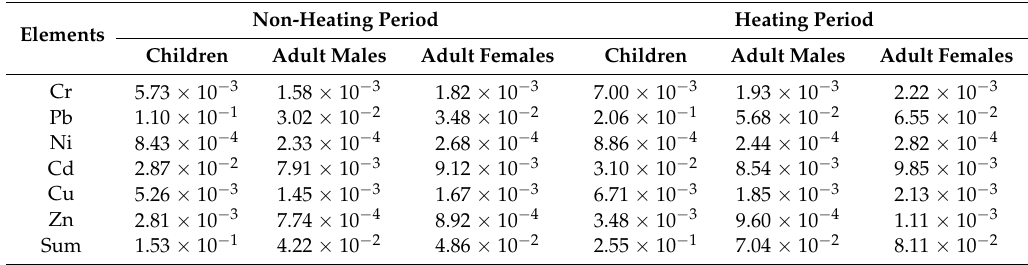
Table 7. The non-carcinogenic risks of heavy metals via the dermal exposure